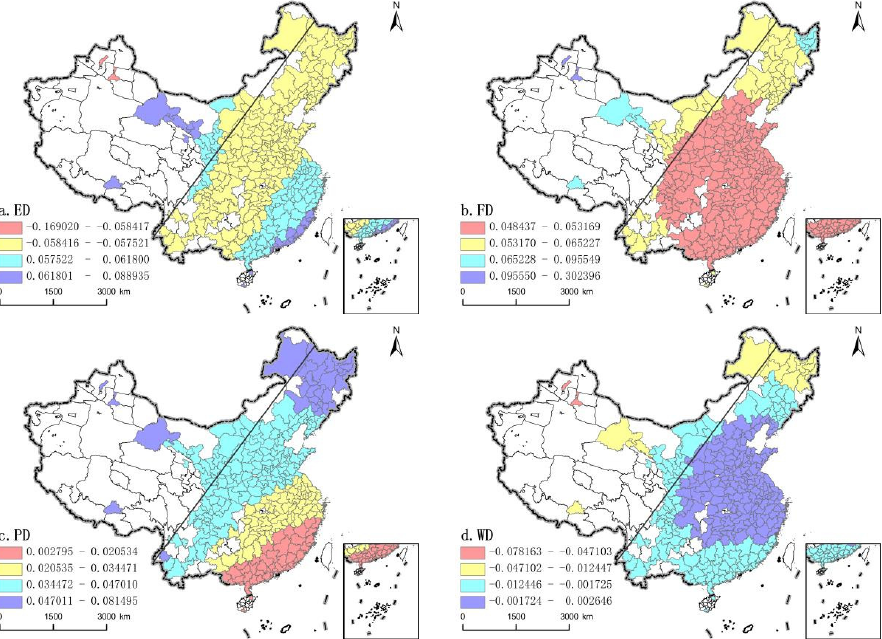
Figure 5. The spatial coefficient distribution of external driving force ( a ) economic density, ( b ) fi- nancial density, ( c ) population density, ( d ) water resource density. cial density, ( c ) population density, ( d ) water resource